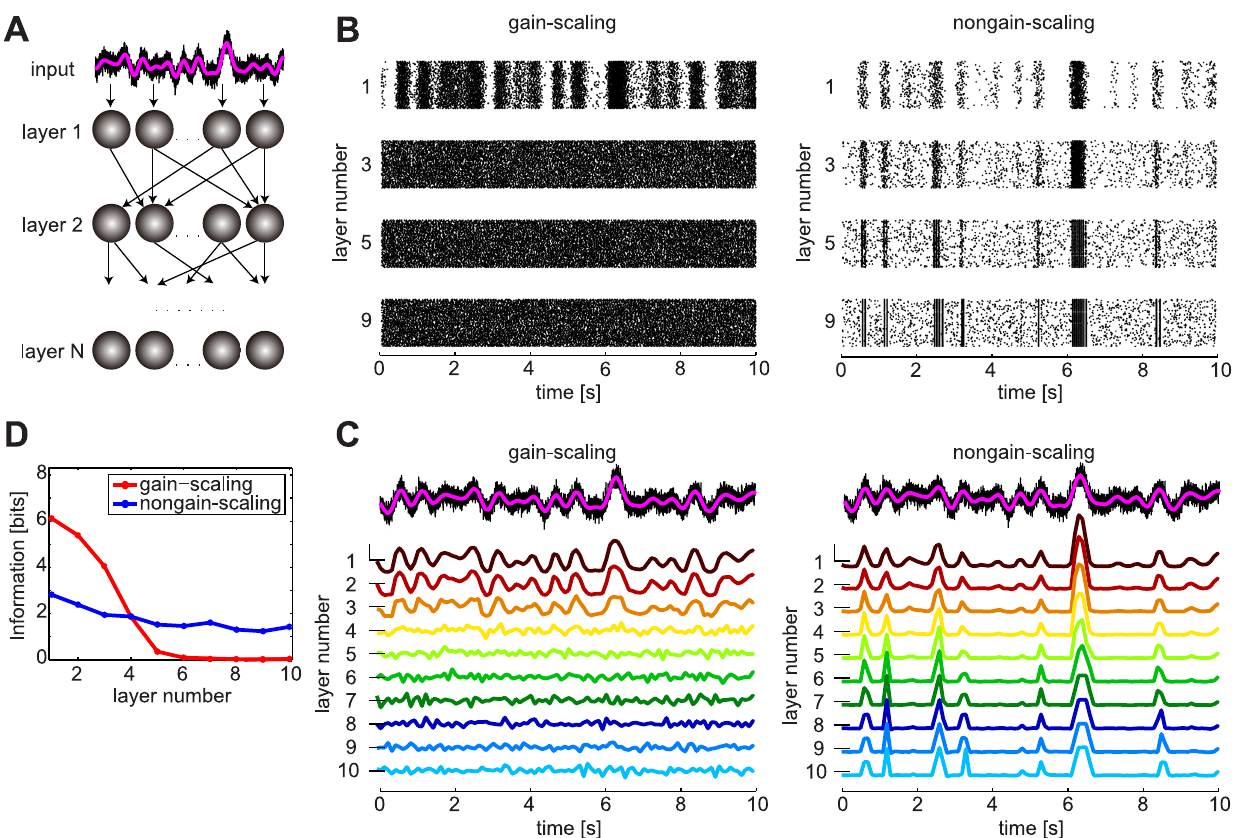
Figure 4. Information transmission through GS and NGS networks. A . Feedforward network with a slowly modulated time-varying input (magenta) presented to all neurons in the first layer, each neuron receiving in addition an independent noisy signal (black). B . Spike rasters for GS neurons ( G K ~ 1000 pS/ m m 2 and G Na ~ 1500 pS/ m m 2 ) show the rapid signal degradation in deeper layers, while NGS neurons ( G K ~ 1000 pS/ m m 2 and G Na ~ 600 pS/ m m 2 ) exhibit reliable signal transmission of large-amplitude events. The spiking responses synchronize in deeper layers. C . PSTHs from each layer in the two networks showing the propagation of a slow-varying input in the presence of background fast fluctuations. PSTHs were normalized to mean 0 and variance 1 to illustrate fluctuations (in spite of different firing rates) so that the dashed lines next to each PSTH denote 0 and the scalebar 2 normalized units. D . Information about the slow stimulus fluctuations conveyed by the population mean responses shown in